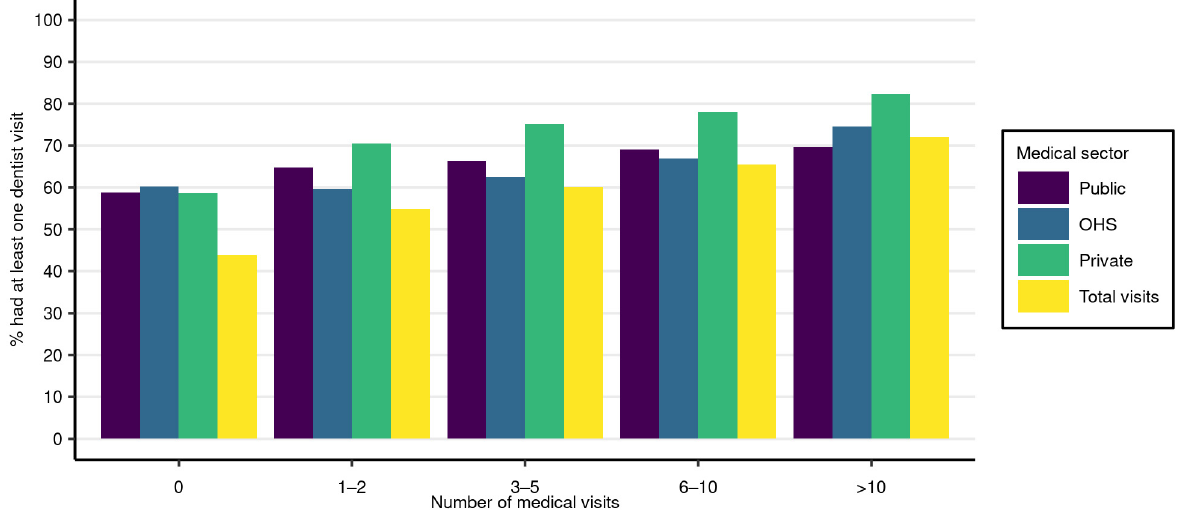
Figure 2. Proportions of residents with a dentist visit, by number of medical visits and sector. The proportions for each bar are calculated separately within each medical visit bin and sector. Note that a resident may have medical visits in more than one